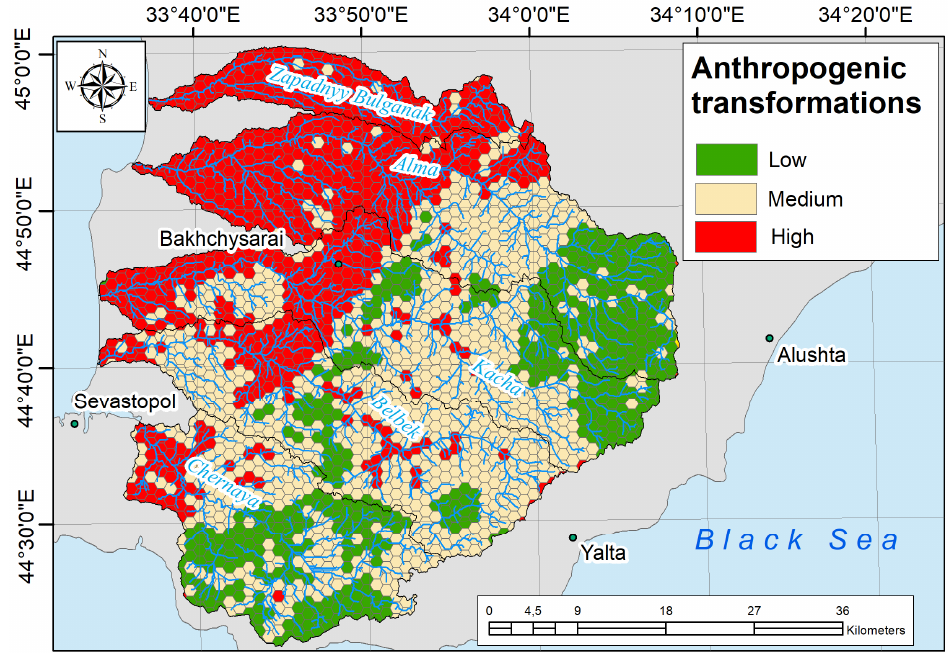
Figure 3. Anthropogenic transformation of the river basins of the northwestern slope of the Crimean Mountains. Crimean